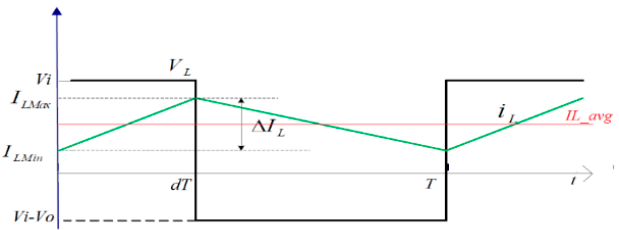
Figure A1. Pulse Width Modulation (PWM) signal controlling the switch K . From Equations (A1)–(A4), the current curve through the inductance and its voltage are represented in Figure A2.